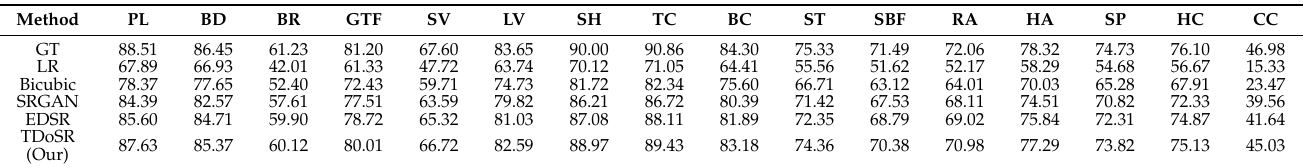
Table 2. The recognition accuracy of various targets after the reconstruction by different super-resolution methods. Method